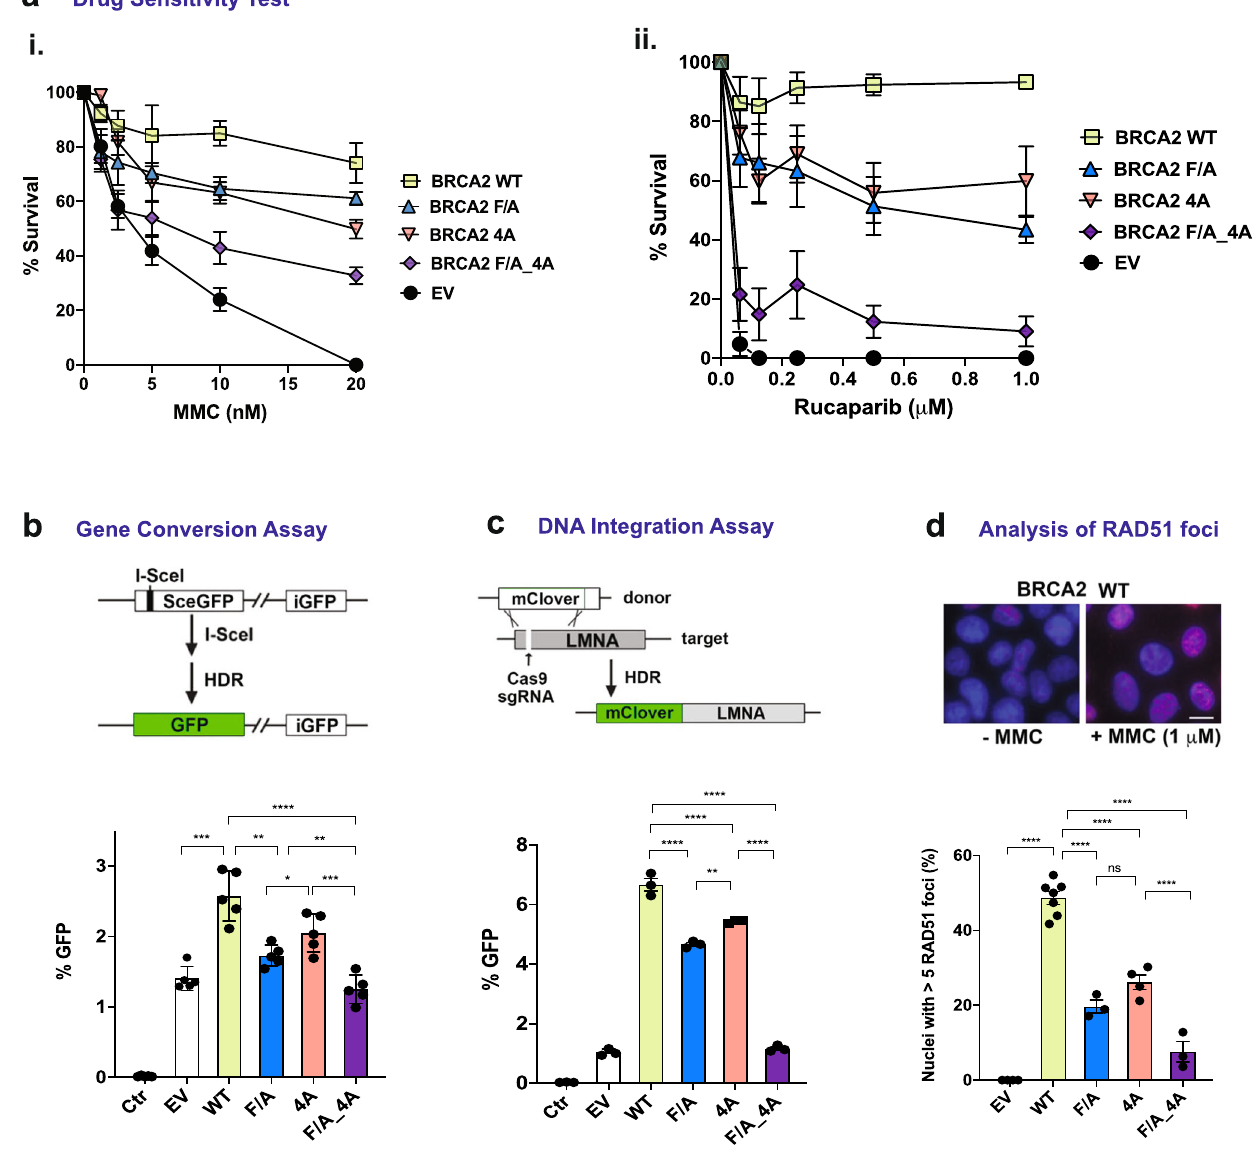
Fig. 5 | Signi fi cance of CTRB attributes in DNA damage repair. a Clonogenic survival of DLD1 cells expressing wild-type BRCA2 or BRCA2 variants with the indicated CTRB mutation (F/A, 4A, or F/A-4A) after treatment of MMC or Ruca- parib. EV: empty vector. ( n =4 biologically independent experiments for MMC, meanvalue±SEM; n =3biologicallyindependentexperimentsforRucaparib,mean value±SD). Source data are provided in the Source Data fi le. b HR pro fi ciency was measured using the DR-GFP gene conversion reporter in HeLa cells depleted for endogenous BRCA2 and expressing BRCA2 or BRCA2 variants with the indicated CTRB mutation. Ctr (control): not treated. ( n =5 biologically independent experi- ments; mean value±SD; unpaired t -test (two-tailed); * p =4.928×10 − 2 ; ** p <0.01; *** p <0.001; **** p <0.0001. p value between the WT group and the EV group is 1.608×10 − 4 ;fortheF/Agroupis1.116×10 − 3 ;betweentheF/AgroupandtheF/A_4A group is 2.898×10 − 3 ; between the 4A group and the FA_4A group is 7.481×10 − 4 ).